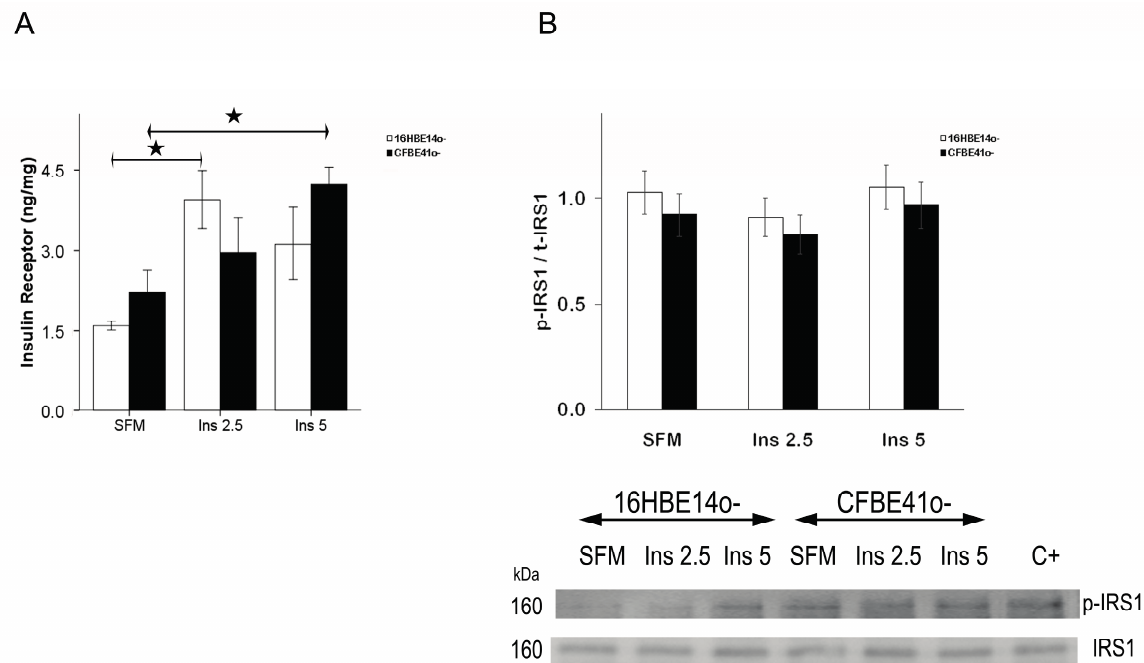
Figure 1. Total insulin receptor (IR) content ( A ), activated [Y941]/total insulin receptor substrate type 1 (IRS1) ratio (p-IRS1/t-IRS1) in normal and CF-affected cells ( B ). ( A ) IR content in CFBE41o- cells was similar to that in 16HBE14o- cells both in serum-free medium (SFM) and after treatment with insulin at 2.5 and 5 ng/mL. In 16HBE14o- cells, IR increased significantly with treatment; ( B ) IRS1 was quantified by Western immunoblotting after immunoprecipitation, p-IRS1/t-IRS1 content in CFBE41o- cells was similar to that in 16HBE14o- cells both in serum-free medium (SFM) and after treatment with insulin at 2.5 and 5 ng/mL. Beneath is a representative immunoblot showing tyrosine 941 phosphorylated IRS1 and total IRS1 in both cell types. C+: positive control. The bars represent the mean ± SEM of the ratios for four experiments in both cell types. p < 0.05 SFM vs . insulin